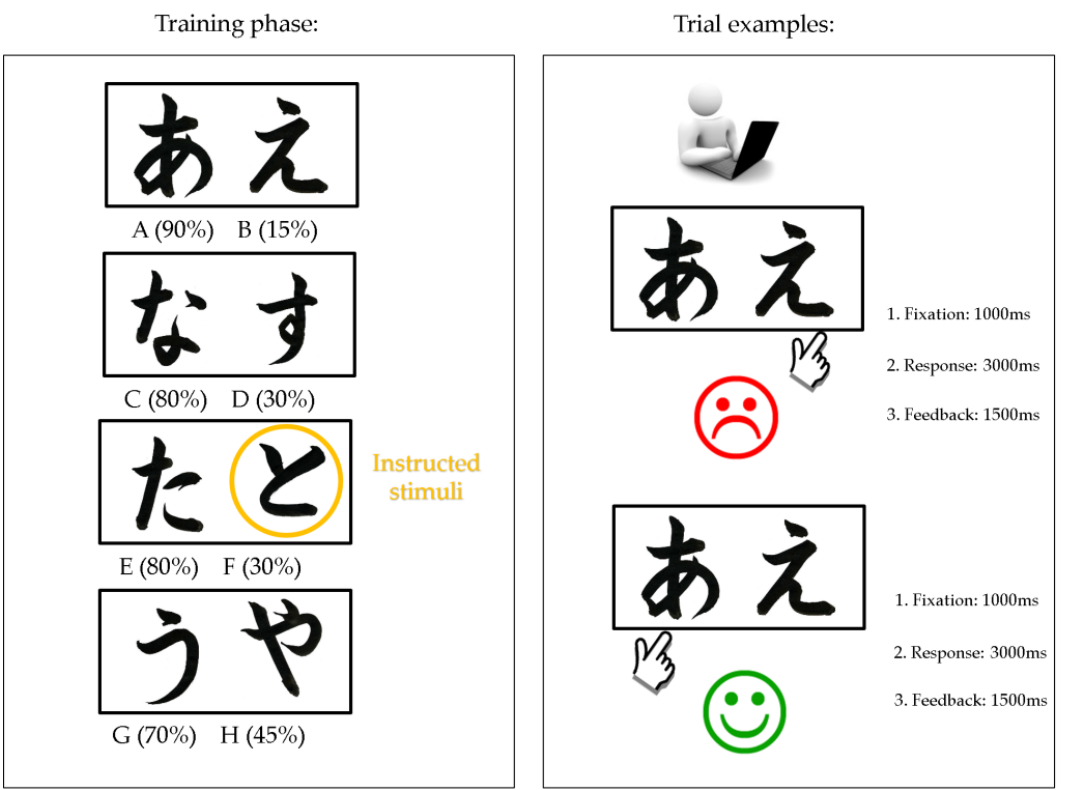
Figure 1. Probabilistic contingencies during training phase of IPST AB (90%/15%), CD (80%/30%), EF (80%/30%), and GH (70%/45%) conditions and trial examples with negative and positive feed- back.